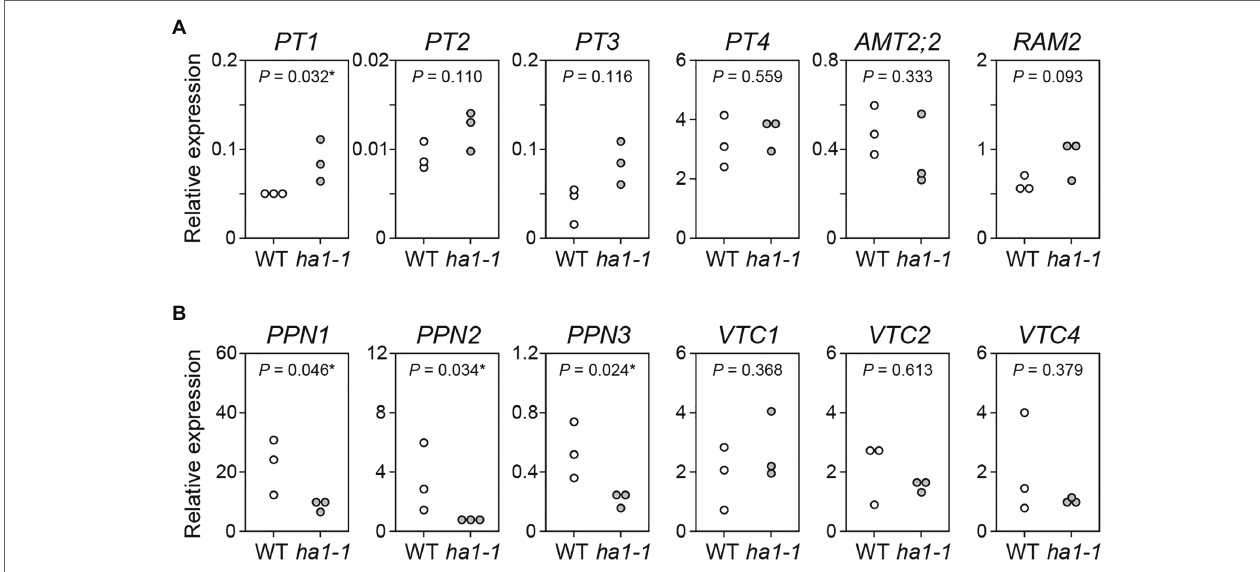
FIGURE 9 | Gene expression analysis. (A) Expression of L. japonicus genes encoding phosphate transporters ( PT1 – PT4 ), ammonium transporter ( AMT2;2 ), and AM-specific glycerol-3-phosphate acyltransferase RAM2 gene in mycorrhizal roots of the wild-type and ha1-1 4 weeks after inoculation with R. irregularis . Expression levels were normalized based on the amount of L. japonicus EF2 . (B) Expression of R. irregularis genes encoding endopolyphosphatases ( PPN1 – PPN3 ) and vacuolar transporter chaperones ( VTC1 , VTC2 , and VTC4 ) in mycorrhizal roots. The R. irregularis EF1 β gene was used as an internal control. p -values are based on Student’s t -test (*, p <